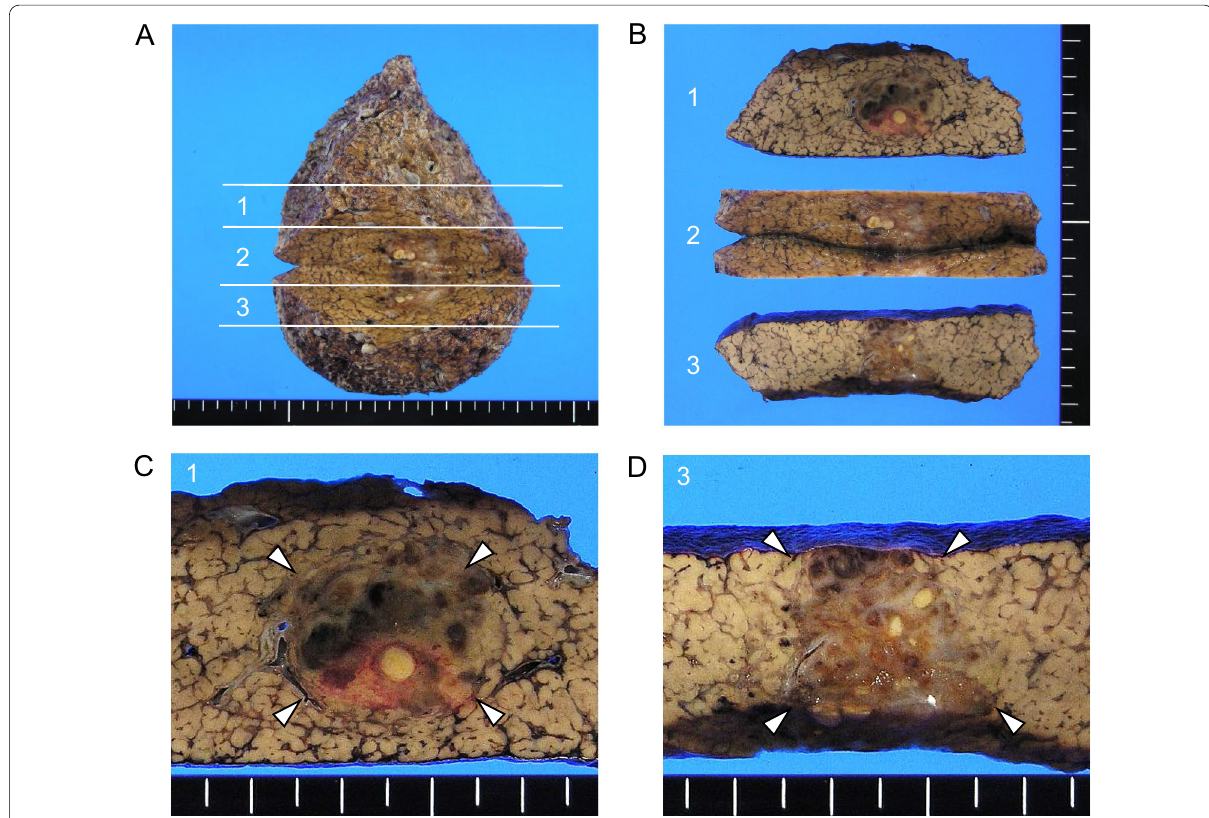
Fig. 4 Gross appearance of surgically resected specimen. The resected specimen ( a ) was cut into thirds ( b ). The cut surface showed a tumor with a heterogeneous appearance ( c and d , arrowheads) without fibrous capsule. The background liver was